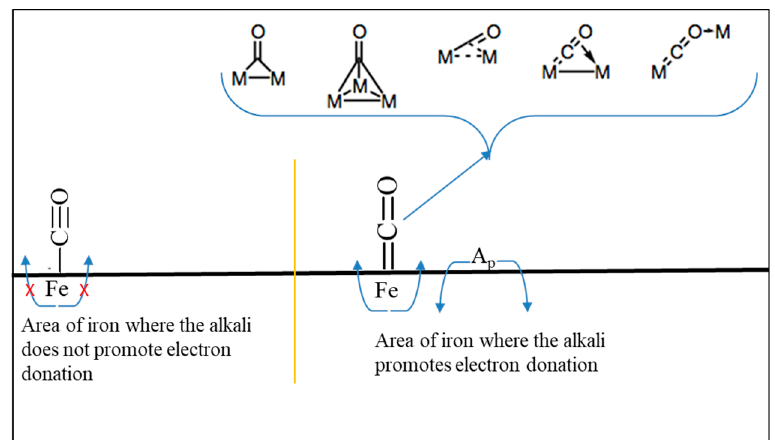
Figure 37. This figure describes types of possible bonding for CO depending on electronic effects that are caused by the addition of a promoter (A p ), such as the Group I alkali series. As observed with the vinylic intermediate, as the size of the promoter increases, so does the iron surface area that it affects. As the alkali basicity increases, so does its ability to assist in back donation of electron density.